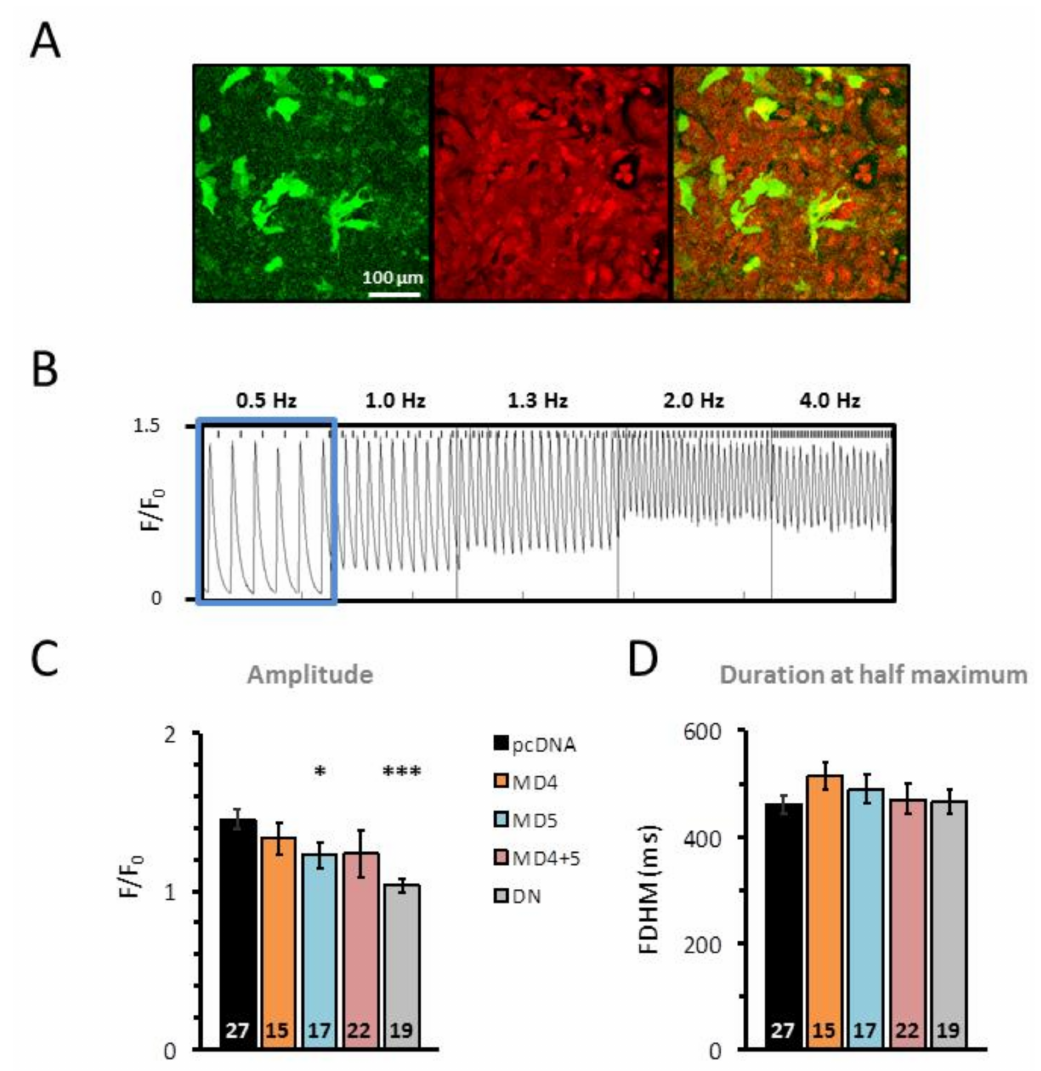
Figure 3. Impact of Pitx2 mutations on calcium transients. Panel ( A ). Images of a HL1 myocyte culture co-transfected with GFP and pcDNA (left). The middle panel shows calcium imaging of the same culture and the right panel shows these two images superimposed. Panel ( B ). Calcium transients recorded at increasing stimulation frequencies from the image field shown in panel A. Calcium transient properties were measured at 0.5 Hz where all preparations responded to electrical field stimulation. Panel ( C ). Calcium transient amplitude in HL1 cultures transfected with pcDNA, MD4, MD5, MD4+5 or DN Pitx2 constructs. Panel ( D ). Duration of the calcium transients at half maximum. Number of experiments is given for each bar. Values significantly different from pcDNA are indicated with * p < 0.05; *** p <